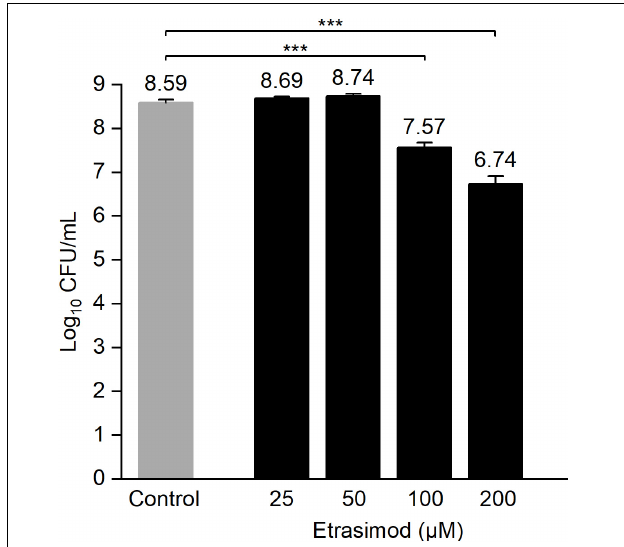
FIGURE 2 | Log 10 of the colony-forming unit (CFU) count of Staphylococcus aureus biofilms exposed to different concentrations of etrasimod for 24 h in post-exposure. Untreated biofilms were used as controls. Results are the average of three biological repetitions, each with two biofilm replicates per concentration (*** p < 0.001).